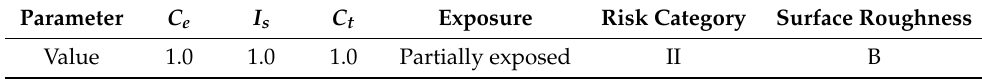
Table 4. Snow load parameters.